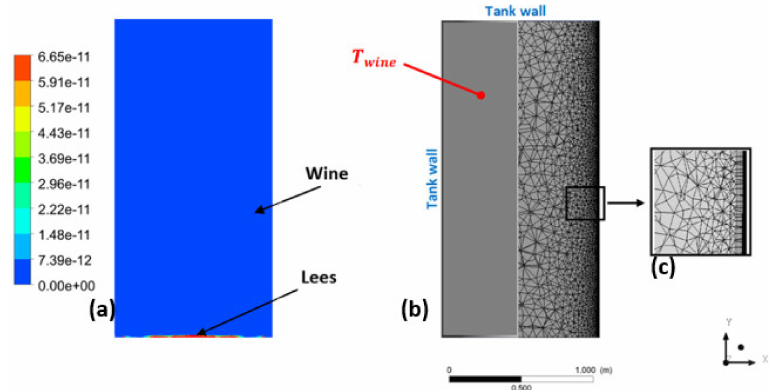
Figure 4. Volume fraction of light lees in the liquid bulk ( a ). Superposition of the geometry of the tank (left) and the mesh of the fluid domain (right) ( b ). Meshing of the fluid domain and detail of the refinement of the mesh close to the wall ( c ).